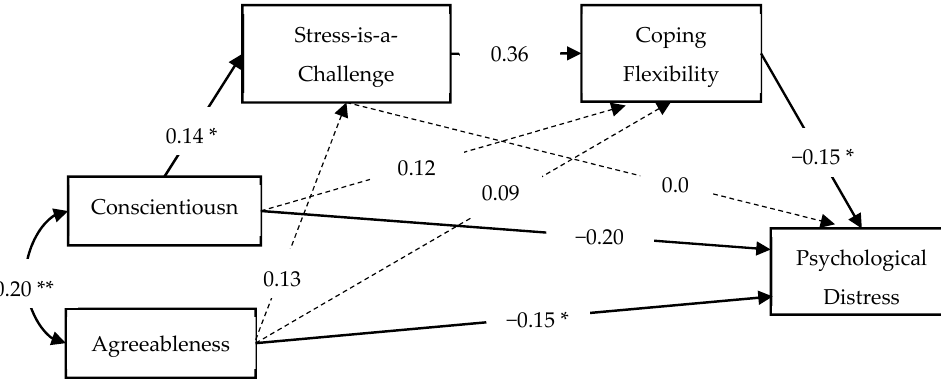
Figure 3. Conscientiousness and the challenge–flexibility–enhancement pathway. Standardized coefficients are presented. Non-significant paths are denoted using dashed lines. ** p < 0.01; * p < 0.05.